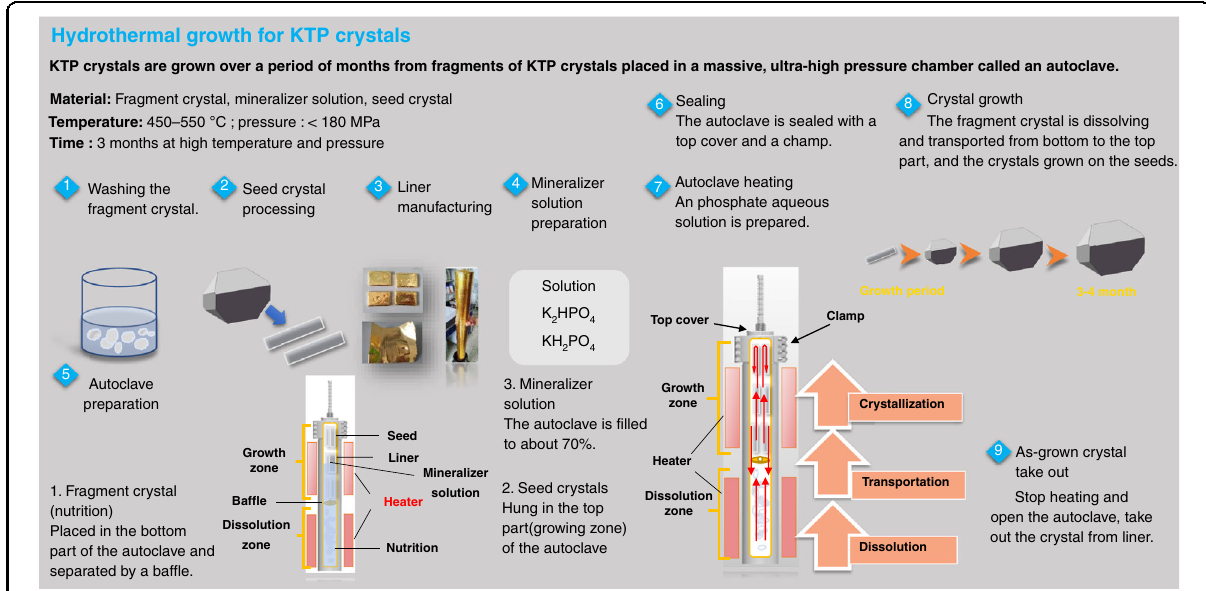
Placed in the bottom part of the autoclave and separated by a baffle. Fig. 4 Production process of bulk KTiOPO4 crystal by hydrothermal method. Hydrothermal method is the process of crystal growth under hydrothermal conditions occurs at high regimes and pressures. Therefore, this process leads in special thick-walled vessels – autoclaves, made of special high-strength corrosion and heat-resistant steel. The typical hydrothermal growth process of KTP crystal includes nine steps, starting with the preparation work of nutrients, seed, liner, mineralizers, and autoclave etc. (step 1 – 5), and fi nally taking out the grown crystals (step 9) after autoclave sealing, heating and crystal growth (step 6 –